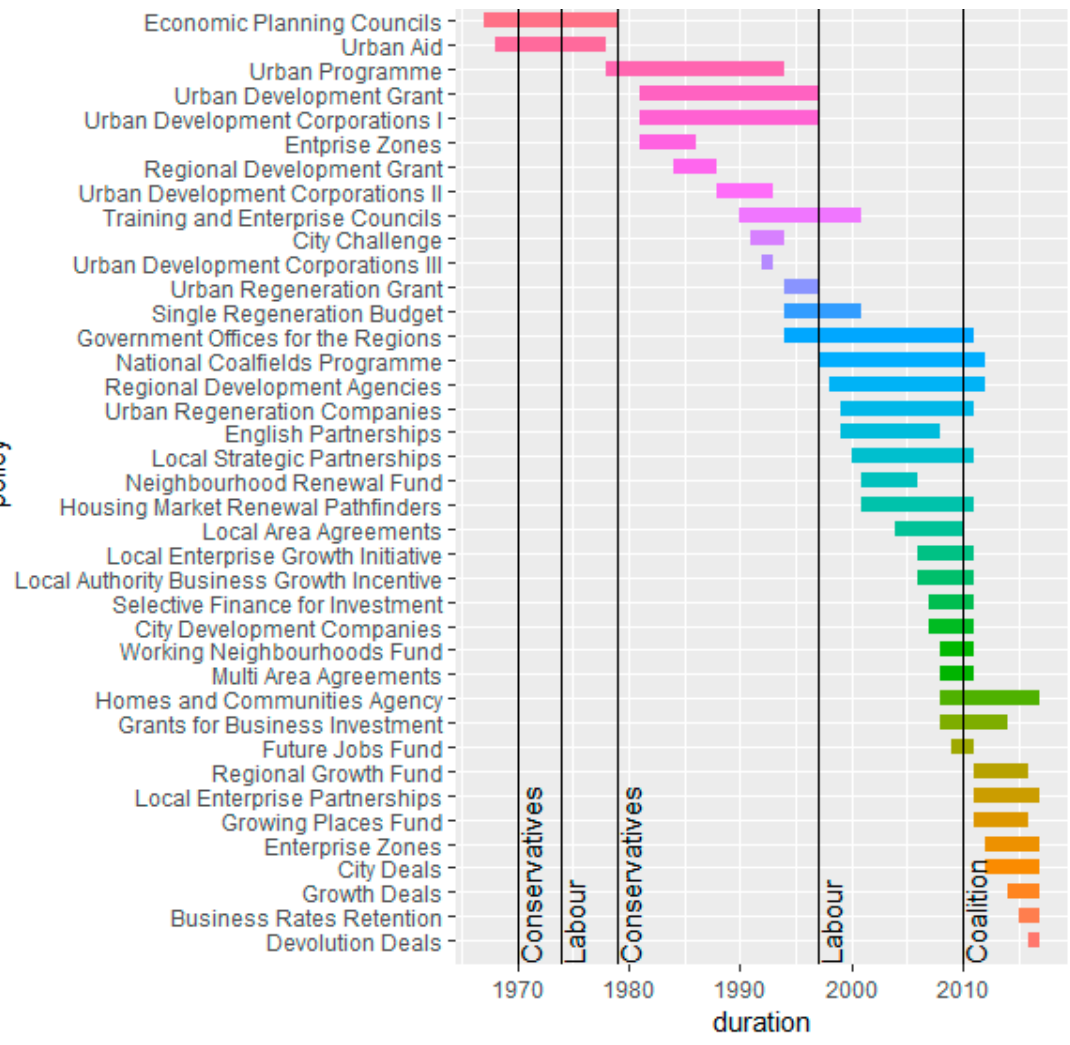
Figure 4. A time line of decentralisation and urban/regional policies in England, along with changes in U.K. Government, 1968–2016 (Source: author research of policy documents).